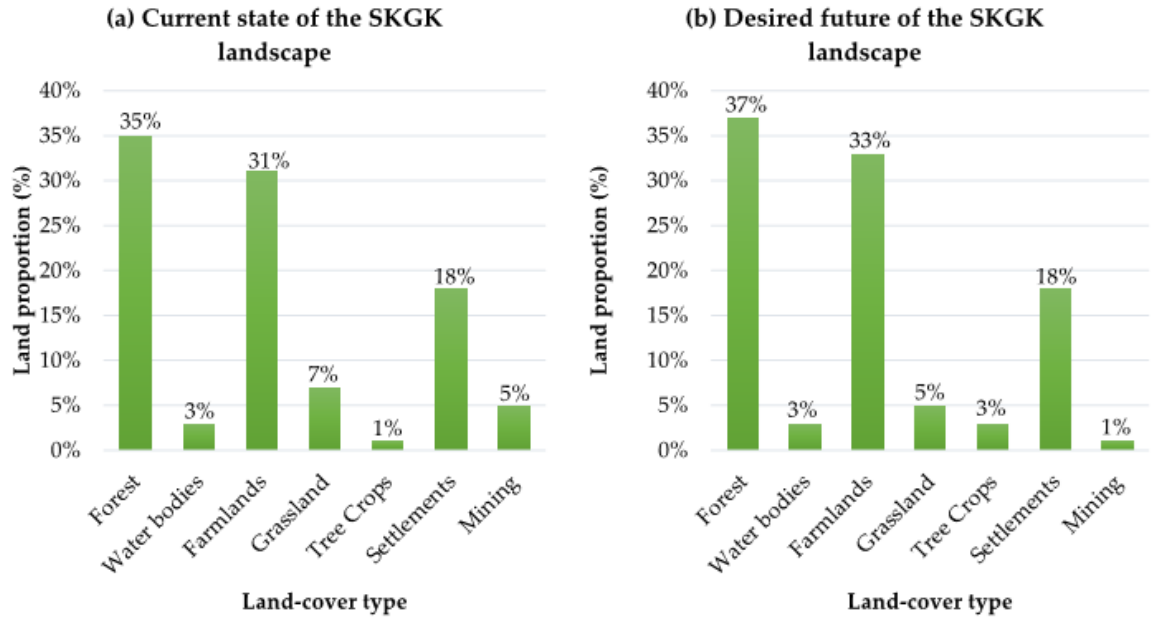
Figure 8. Consensus perception of the current state ( a ) and desired future composition ( b ) of the Sanyiga Kasena Gavara Kara (SKGK) landscape.